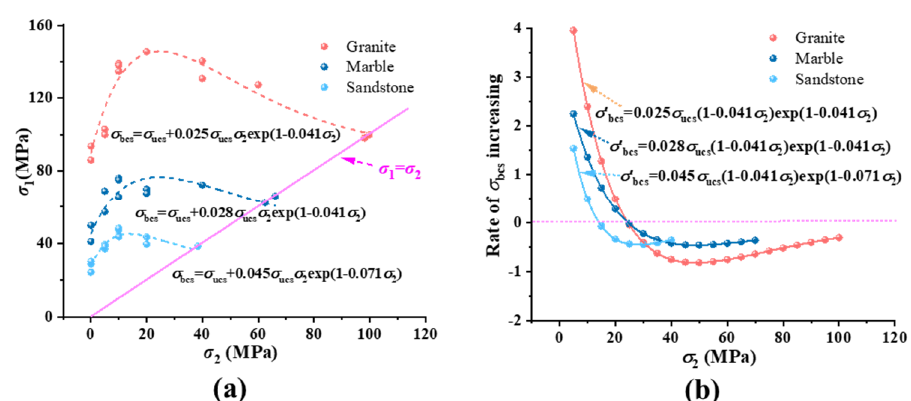
Figure 8. Strength characteristics including ( a ) biaxial compressive strengths and the associated fitting curves, and ( b ) the increasing rate of σ bcs for granite, marble, and sandstone.